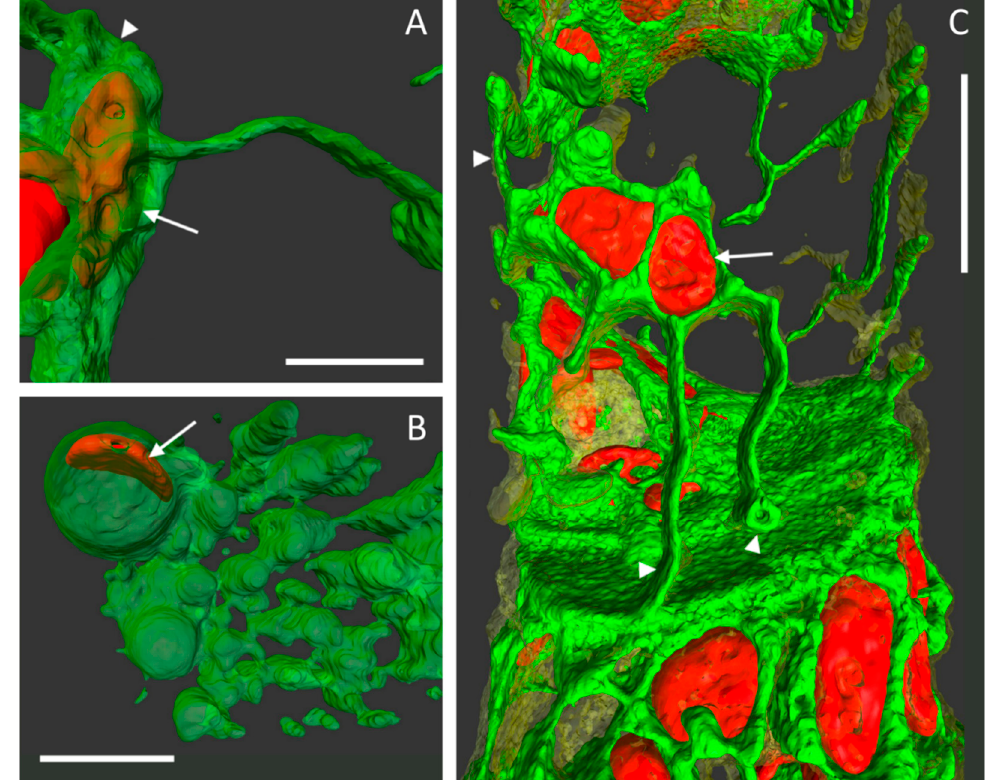
Figure 5. High magnification of 3D reconstructions in plasmolyzed protonema cells. ER encloses chloroplasts (arrows) as the protoplast shrinks and detaches from the cell wall. ER (green), chloroplasts (red) and PM (transparent yellow, only in C ). ( A ) A little portion of the protoplast (arrowhead) stayed attached to the adjoining cell wall of two cells and is connected by a plasma strand with the main protoplast. Transparently colored ER encloses a chloroplast. ( B ) After increasing the transparency levels of ER stacks and bubbles, a chloroplast (arrow) is revealed. ( C ) The close up of the cell pair in Figure 3B–F reveals a partial protoplast detachment from the walls, with fine membrane strands and tubules of ER (Hechtian reticula), and even a small ring, remaining attached at the lateral cell wall (arrowheads in C ). Scale bars: A and B = 5 µm; Scale bar: C = 10 µm.